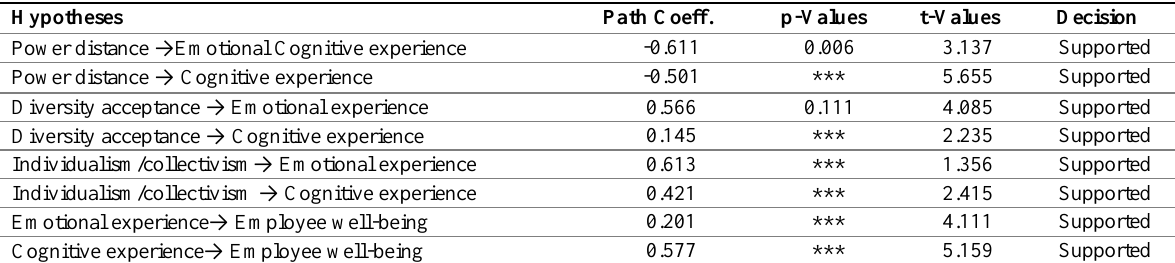
Table 5: Hypotheses testing